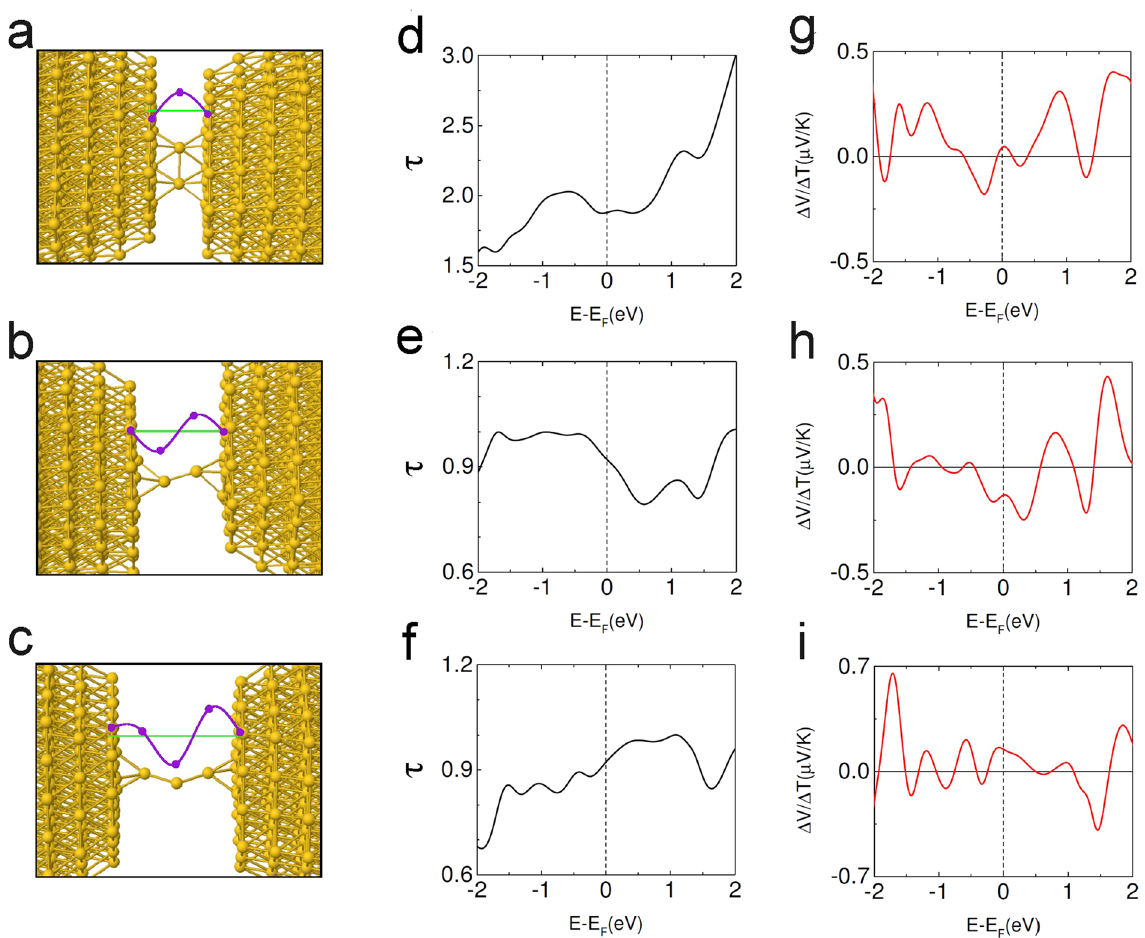
Figure 4. Mechanical manipulation of quantum interference and thermoelectric effect of Au junction undergoing strain-induced conformational changes. Junctions of two electrodes bridged by ( a ) two gold atoms in parallel as in Fig. 2bI, ( b ) two gold atoms in series as in Fig. 2bII, ( c ) a chain of three gold atoms. The model structures in ( a ) and ( b ) each consist of 468 atoms, while structure ( c ) has 469. Purple dots show calculated values of the real part of a typical electron transport wave function < 6 s| Ψ> in the junction at the Fermi level. at a mean temperature of 27 K for the structures ( a–c ). At the Fermi level, Δ V = + 0.70 μ V, − 2.10 μ V and + 2.40 μ V at Δ T = 16 K for ( g ), ( h ) and ( i )